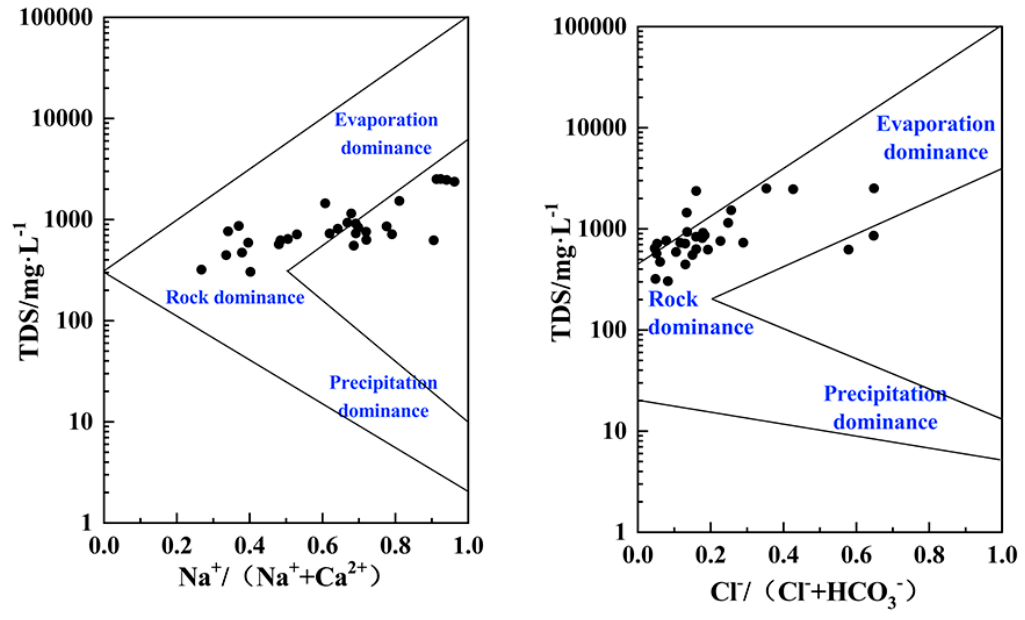
Figure 5. Gibbs diagram of shallow groundwater.